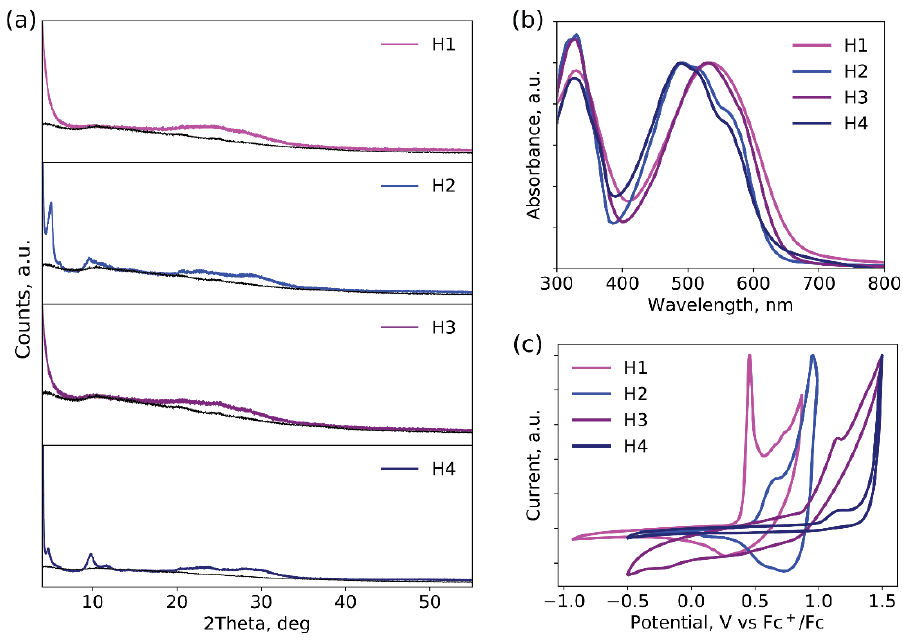
Figure 3. XRD patterns ( a ) absorption spectra ( b ) and cyclic voltammograms ( c ) of H1 - 4 thin films.